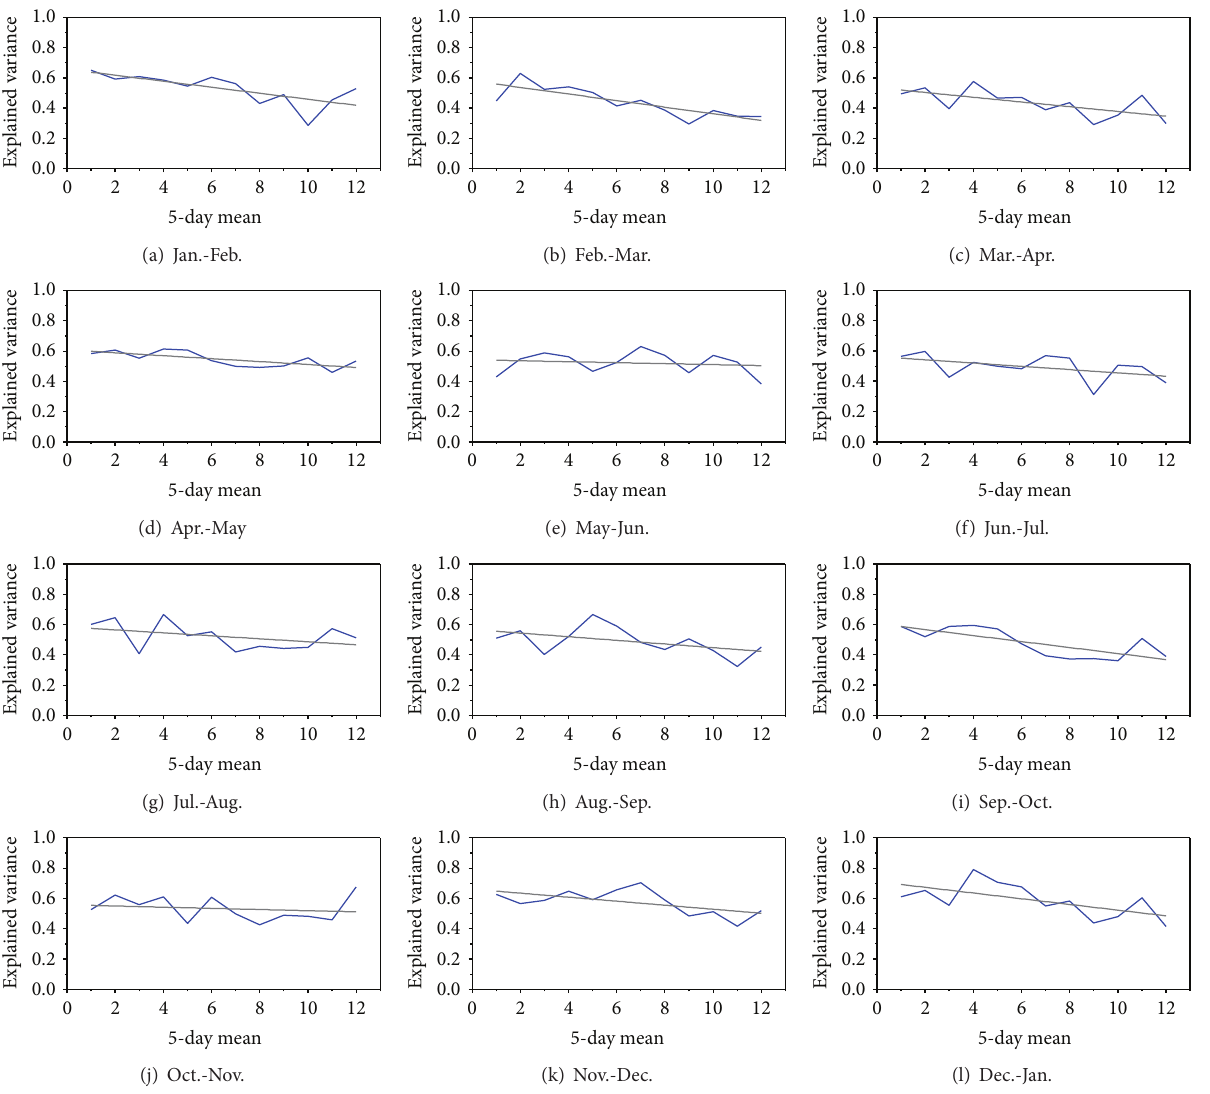
Figure 2: Monthly change in the average explained variance of the three typical years’ pentad averages for the 10–30-day STs of the Northern Hemisphere 500 hPa height field. The gray line denotes the linear